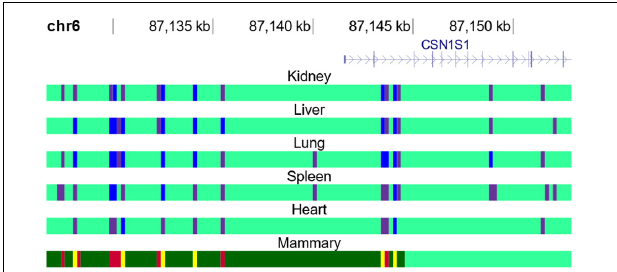
FIGURE 5 | ChromHMM states vary between tissues. Representation of ChromHMM states in heart, kidney, liver, lung, spleen, and mammary gland tissue near the transcription start site of CSN1, a gene highly expressed in the mammary gland. “Inactive promoter” (blue), “Repressed” (purple) and “No Signal” (light green) states are all inactive states, while “Active Enhancer” (red), “HyperChIPable Region” (yellow), and “Permissive” (dark green) are all active states.